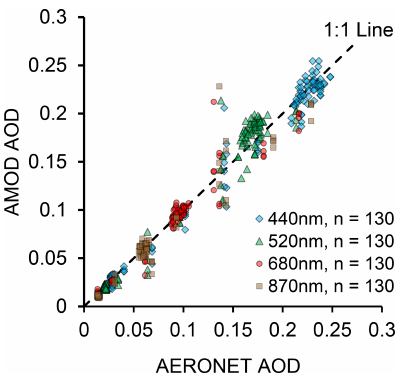
Figure 3. AERONET vs. AMOD AOD comparison plot. This plot includes all co-located measurements taken across all wavelengths between 3 September and 25 November